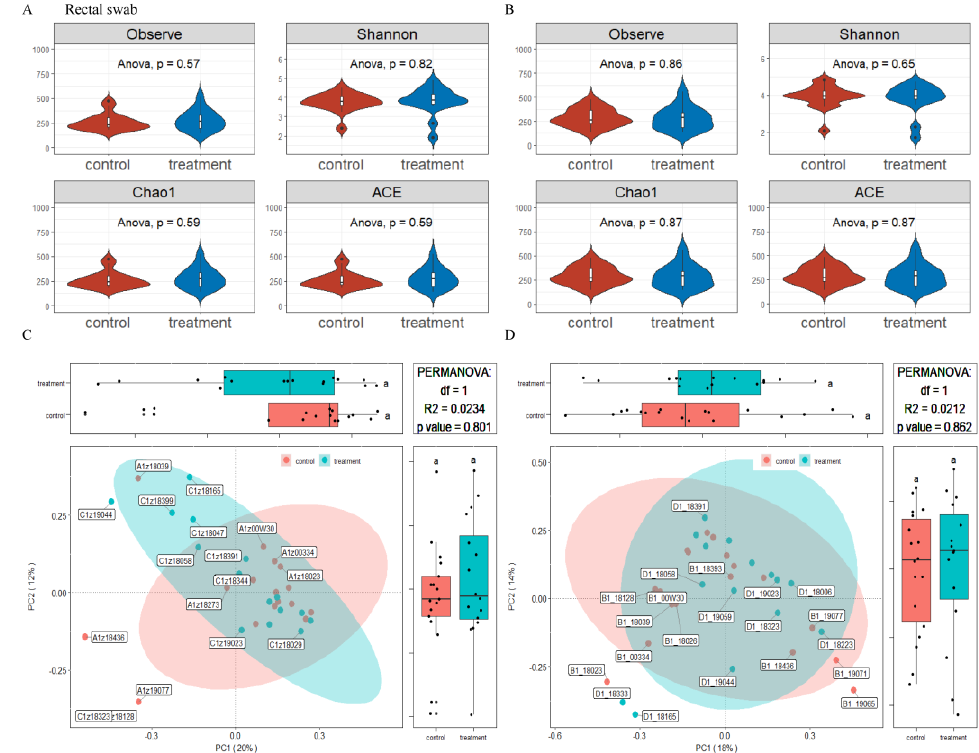
Figure 3. Effects of MSFAs during gestation on the rectal swab microbiota diversity of sows. Comparison of the number of observed species and Shannon, Chao1 and ACE indexes between the control and treatment groups at day 14 ( A ) and day 28 ( B ) of gestation. Beta diversity of the fecal microbiota in sows between the control and treatment groups at day 14 ( C ) and day 28 ( D ) of gestation based on weighted UniFrac distance. Data are expressed as the mean ± SEM ( n = 11).